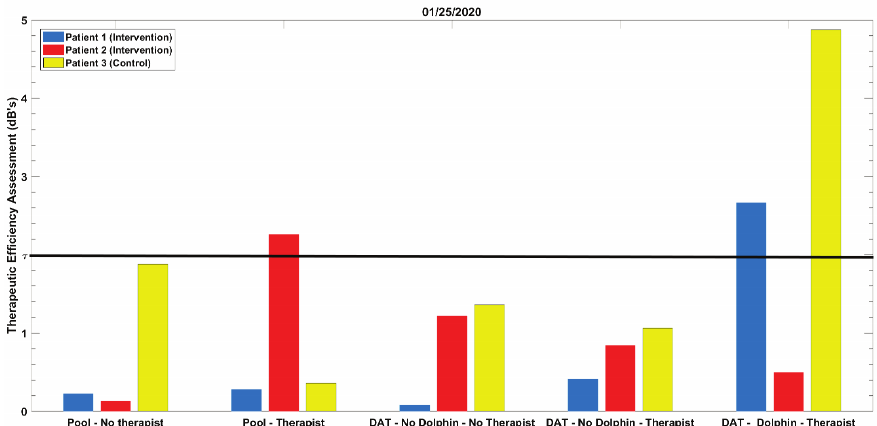
Figure 22. Comparative results of both intervention and control patients for Dolphin-Assisted Therapy taken on 25/01/2020. Continuous line indicates an efficiency threshold of ± 2 dB of